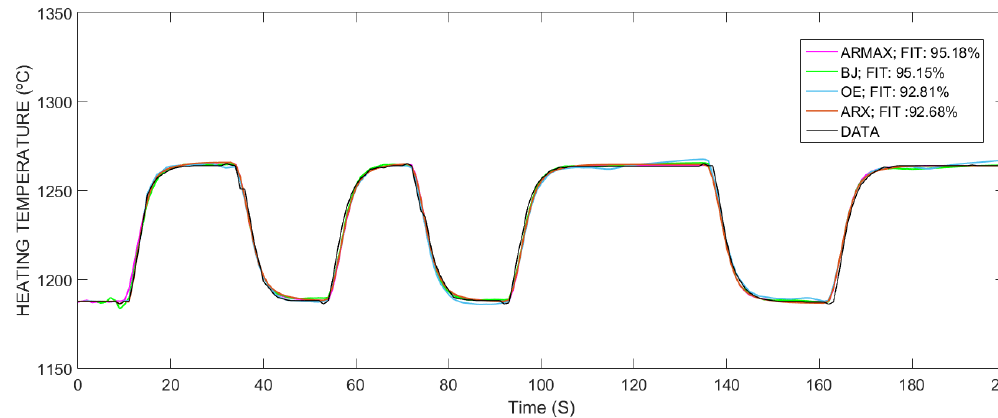
Figure 3. Validation results of the mathematical model obtained.